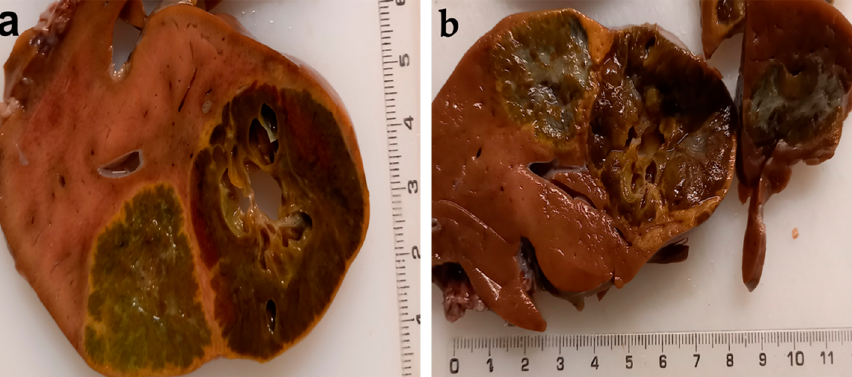
Figure 6. ( a , b ) Postmortem macroscopic pathology shows liver damage (hepatoblastoma).